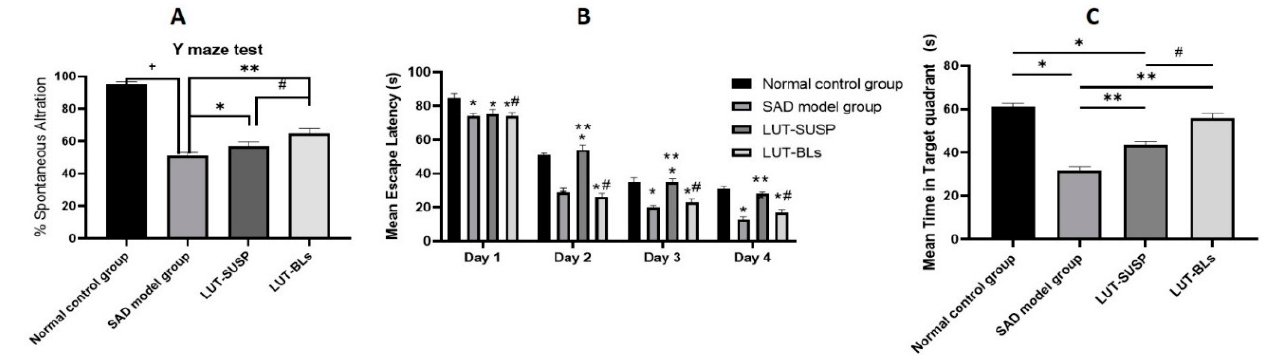
Figure 7. Behavioral assessment of the effect of luteolin bilosomes on ( A ) the percentage of spontaneous alternation, ( B ) mean escape latency in MWM, and ( C ) time spent in the target quadrant in MWM. Animals were divided into four groups (n = 8 in each group), one of which was designated as the normal control group. The second group received STZ (3 mg/kg, ICV) and was thus denoted the STZ group. The remaining two groups were all injected first with STZ (3 mg/kg, ICV) followed by intranasal administration of luteolin suspension (50 mg/kg every day for 21 days) and luteolin- loaded bilosomes (50 mg/kg i.n. for 21 days), respectively. Statistical analyses were performed using one-way analysis of variance (ANOVA) followed by the Tukey post hoc test. +: Statistically significant different from the normal control group (saline) at p < 0.05; * and **: statistically significant different from the positive control group (STZ, 3 mg/kg) at p < 0.05; #: statistically significant different from the luteolin suspension group (50 mg/kg) at p < 0.05. Luteolin bilosomes (equivalent to 50